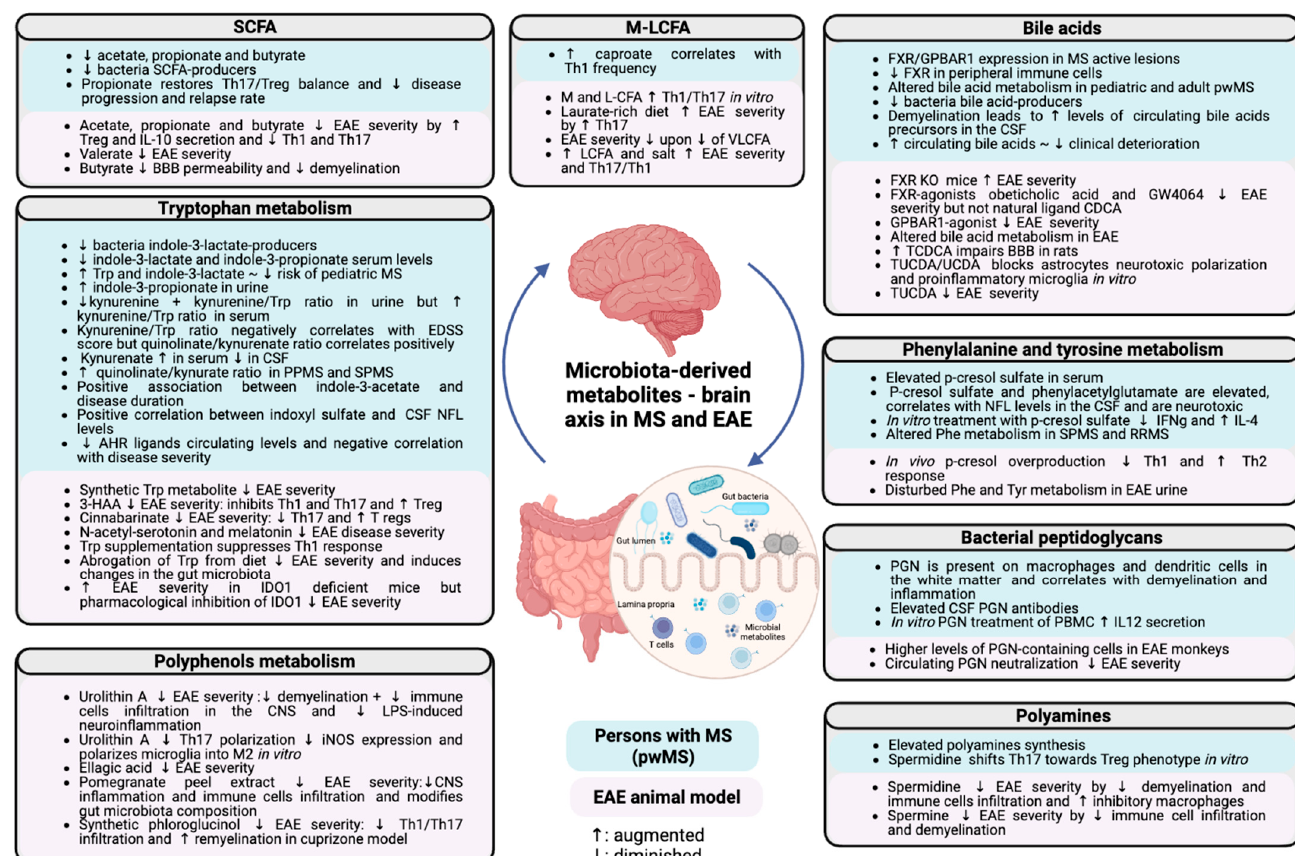
Figure 1. Implications of the different microbiota-derived metabolites in MS pathogenesis. The main concepts described in this review are summarized and separated between human and mice data. SCFAs, short-chain fatty acids; EAE, experimental autoimmune encephalomyelitis; BBB, blood–brain barrier; IL, interleukin; Th, T helper; Treg, regu- latory T cell; MCFAs, medium-chain fatty acids; LCFAs, long-chain fatty acids; VLCFAs, very-long-chain fatty acids; FXR, farnesoid X receptor; GPBAR, G-protein-coupled bile acid receptor; CSF, cerebrospinal fluid; KO, knock-out; TCDCA, taurochenodeoxycholic acid; TUCDA, tauroursochenodeoxycholic acid; UCDA, ursochenodeoxycholic acid; NFL, neurofilaments; IFN, interferon; Phe, phenylalanine; SPMS, secondary progressive multiple sclerosis; RRMS,